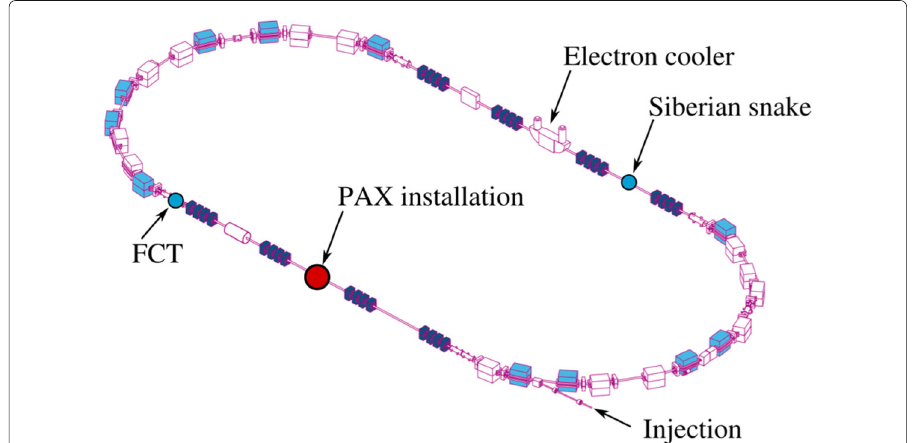
Fig. 5 Schematic picture of the storage ring at the Forschungszentrum Jülich evidencing the location of various components of the experimental setup. The Fast Current Transformer (FCT) is described later in the